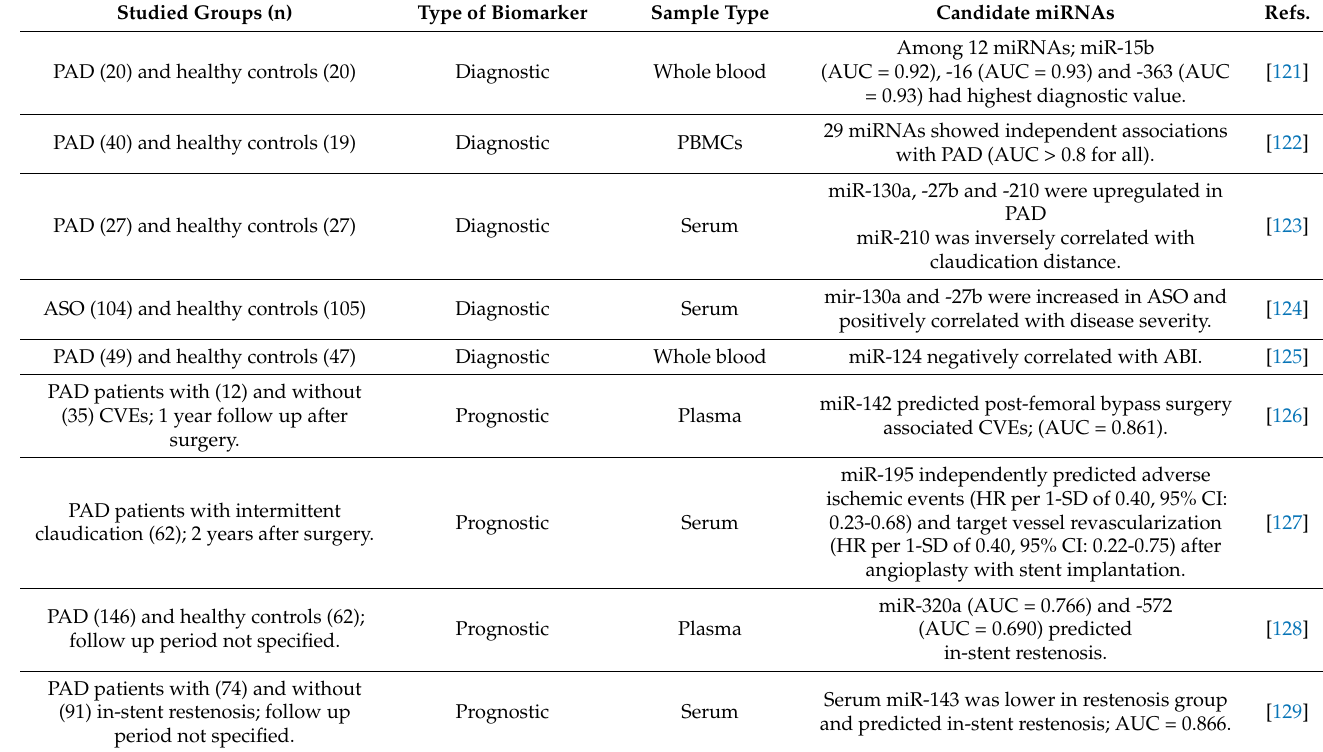
Table 2. Circulating miRNAs as biomarkers in peripheral arterial disease